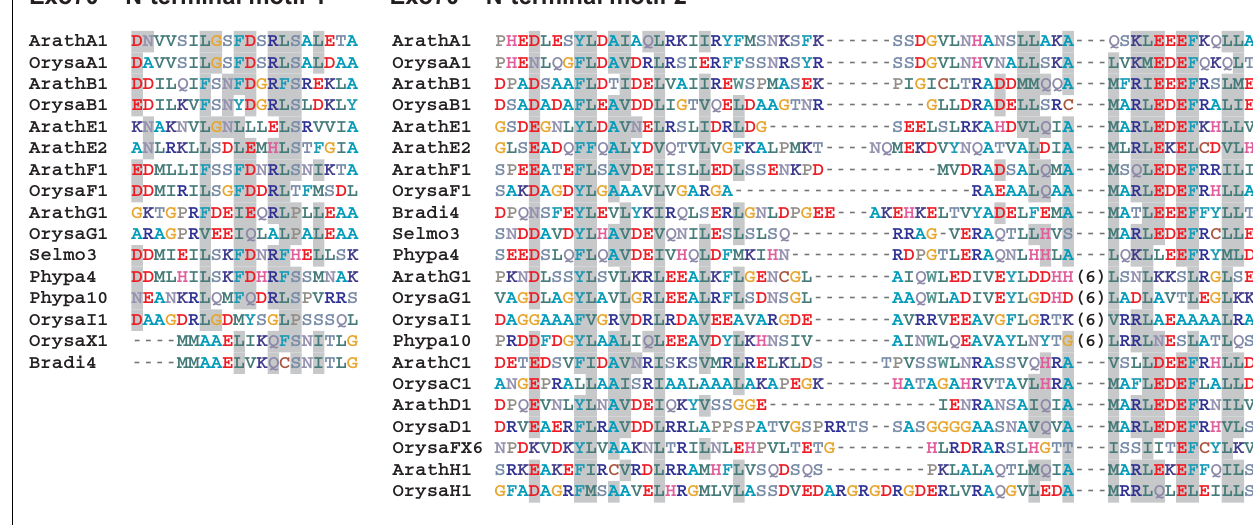
acids from the N terminus. Residues conserved among 75% or more of the sequences containing the motif are shown on a gray background (residue conservation was determined using the Dayhoff matrix). Numbers in brackets indicate the length of variable insertions removed for